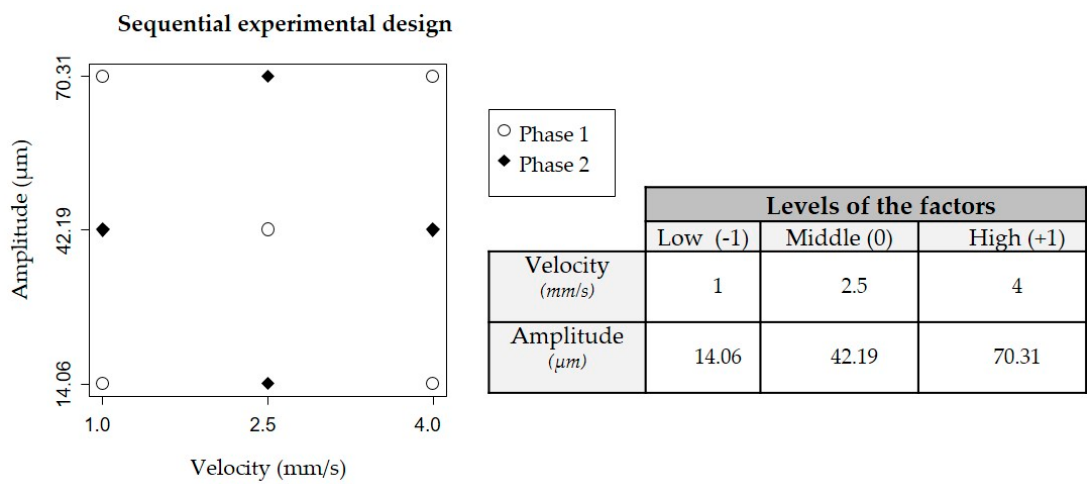
Figure 3. Sequential experimental design: Phase 1 (2 k with a central point) and Phase 2 (3 k ); k = 2. A set of process parameters was kept constant during both experimental phases. Mold